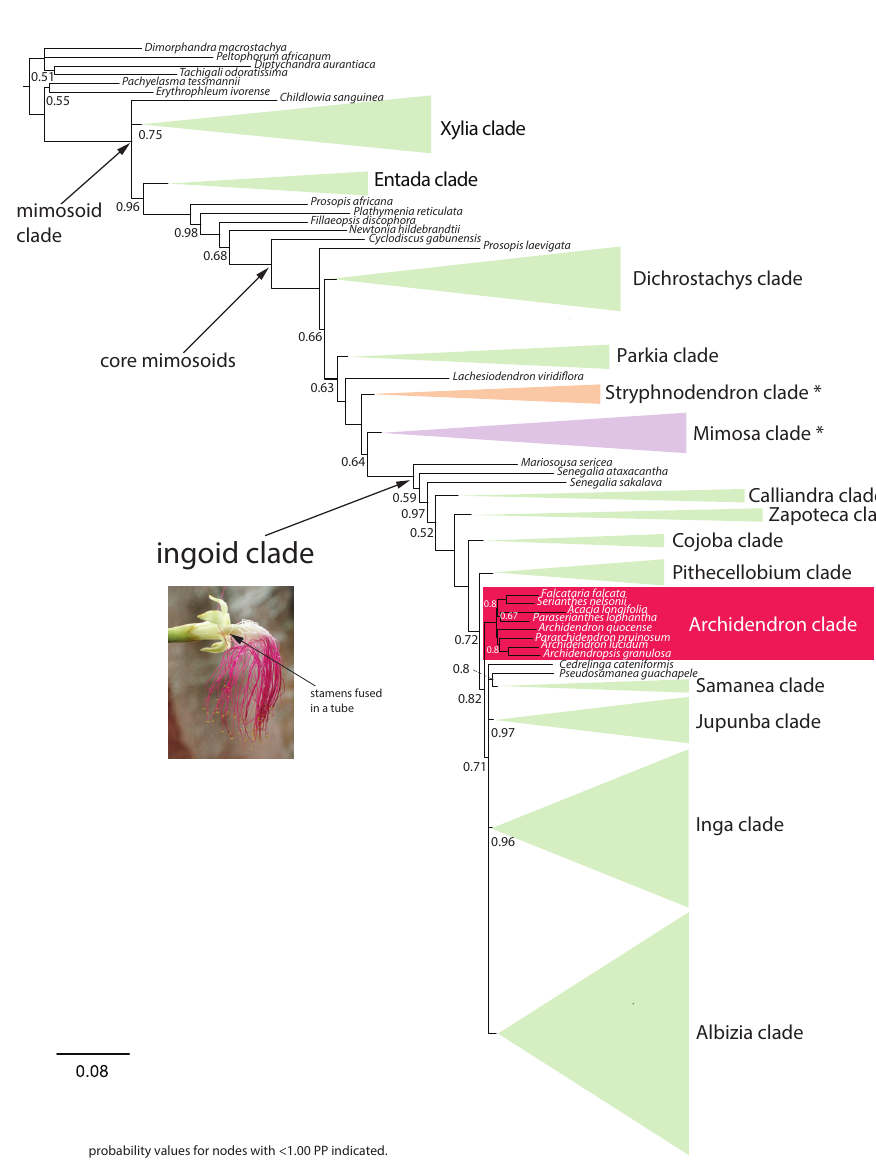
Figure 1. Phylogeny of the mimosoid clade modified from Koenen et al. (2020), based on the mimosoid 964 nuclear dataset with the Archidendron clade highlighted in red. Clade names follow Koenen et al. (2020) with branches collapsed and represented by green triangles. The Stryphnodendron and Mimosa clades, taxa from which were used to root trees in this study, are highlighted in orange and purple, respec- tively and indicated with an